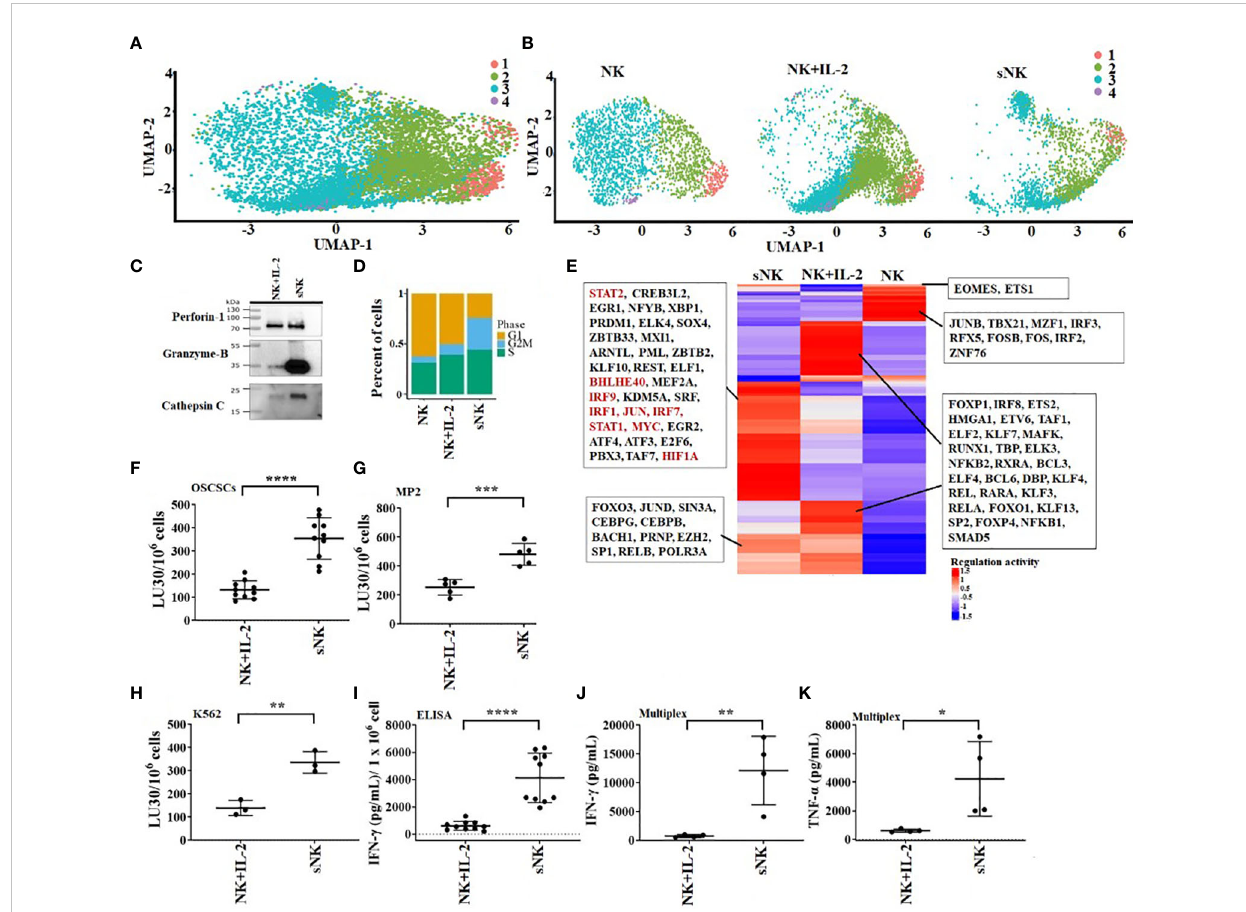
FIGURE 2 OC-expanded supercharged NK cells exhibit higher levels of cytotoxic granules, increased cytotoxicity and augmented secretion of cytokines when compared to primary activated NK cells. OCs were generated as described in the Materials and Methods section. NK cells (0.5x10 6 cells/ 2ml) from healthy individuals were treated with a combination of IL-2 (1000 U/ml) and anti-CD16 mAbs (3 µg/ml) overnight before they were cultured with OCs and sAJ2 at a ratio of 2:1:4 (NK:OCs:sAJ2). Untreated NK cells, IL-2 treated NK cells, and super-charged NK (sNK) cells are used to construct single-cell cDNA libraries for sequencing. UMAP of all of the samples combined (A) or separated (B) are shown. Colors represent different UMAP clusters indicating genetically distinct NK cell subsets. Western blot of protein expression of granzyme B, cathepsin C, and perforin-1 in sNK vs. IL-2 treated primary NK cells derived from the same donor is shown in fi gure (C) . Loading control can be found in Figure S1A. Each cell is assigned a cell-cycle score based on gene markers of different phases. The percentage of cells in each phase is represented in the bar-plot for untreated NK cells, IL-2 treated NK cells, and sNK cells (D) . SCENIC is used to analyze the regulon activity in each condition. Each row of the heatmap represents a regulon, with some highlighted in the box (E) . On day 14 of cultures, another set of NK cells were puri fi ed from healthy donors and were treated with IL-2 (1000 U/ml) overnight. Cytotoxicity of day 15 sNK cells and overnight IL-2 treated primary NK cells was determined using standard 4-hour 51 Cr release assay against OSCSCs (F) , MP2 (G) , and K562 (H) . The Lytic units (LU) 30/10 6 cells were determined using the inverse number of NK cells required to lyse 30% of OSCSCs (n=10) (F) or MP2 (n=5) x 100 (G) or K562 (n=3) x 100 (H) . Primary NK cells were treated with IL-2 as described in Figure 1F, and the supernatants were harvested from day 15 sNK cells or IL-2 treated primary NK cells after an overnight incubation and were used to determine IFN- g secretion using single ELISA. The amounts of IFN- g secretion were adjusted based on 1 x 10 6 cells (n=10) (I) . Primary NK cells were treated with IL-2 as described in Figure 1F, and the supernatants were harvested from day 15 expanded sNK cells or IL-2 treated primary NK cells after an overnight incubation, and they were used to determine IFN- g (J) and TNF- a (K) using multiplex cytokine arrays (n=4). ****(p value<0.0001), ***( p value 0.0001-0.001), **( p value 0.001-0.01), *( p value